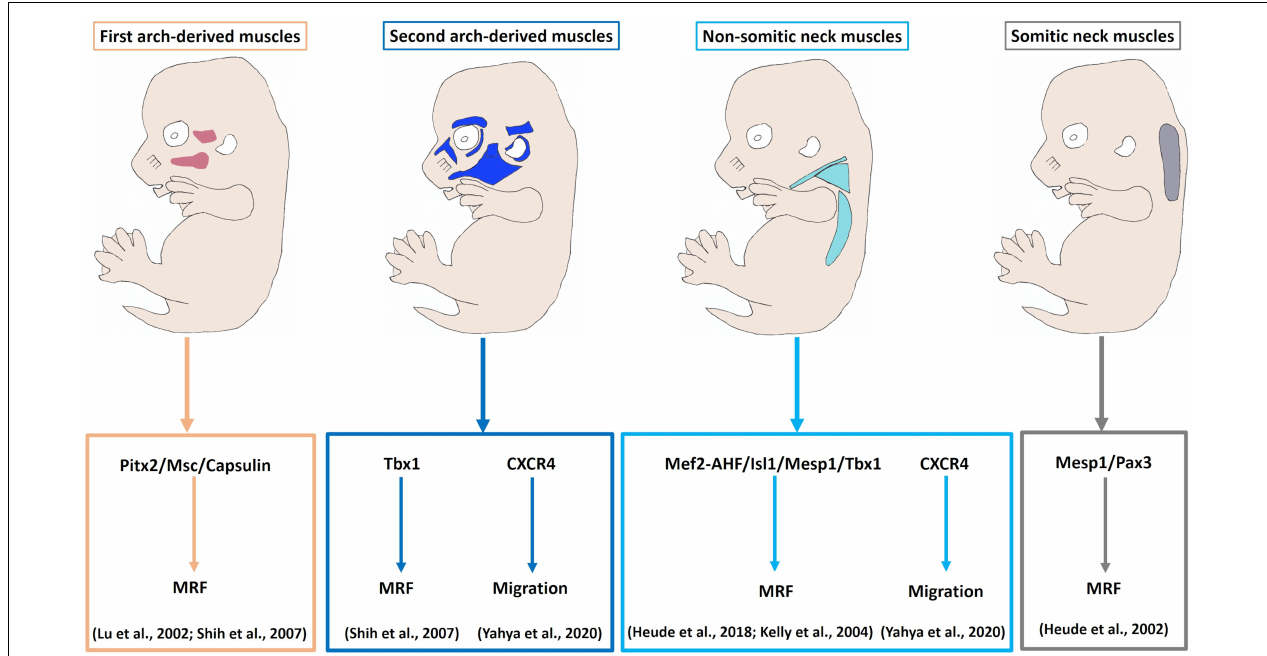
FIGURE 4 | Model of myogenic programs in the facial and neck muscles. Pitx2, Capsulin and Msc are required for the Myf5 and MyoD activation in the BA1-derived muscle progenitor cells. Tbx1 is required for initiation of myogenic progression in the BA2. Non-somitic neck (cucullaris) muscle development is controlled by Mef2c-AHF, Isl1 and Mesp1. The genetic network for somite-derived (epaxial) neck muscles involves both Mesp1 and Pax3 genes. CXCR4 is required for the migration of the BA2-derived and non-somitic neck muscle progenitor cells. MRF, Myogenic regulatory